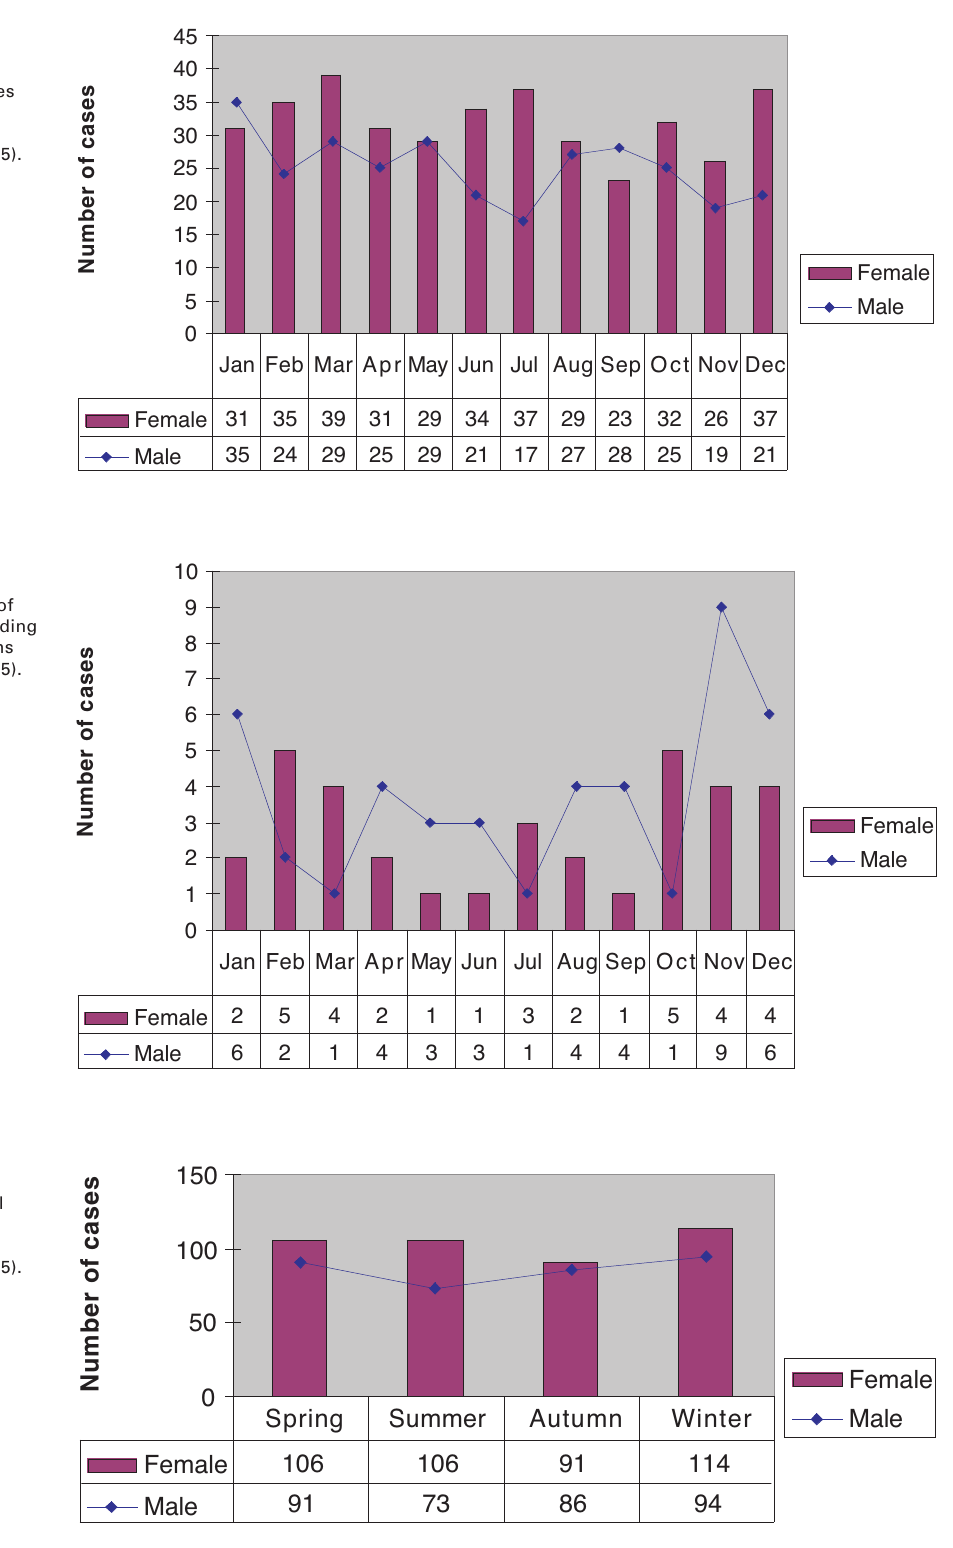
Figure 2 The distribution of aneurysm cases according to sex and months (p = 0.371; p >0.05).